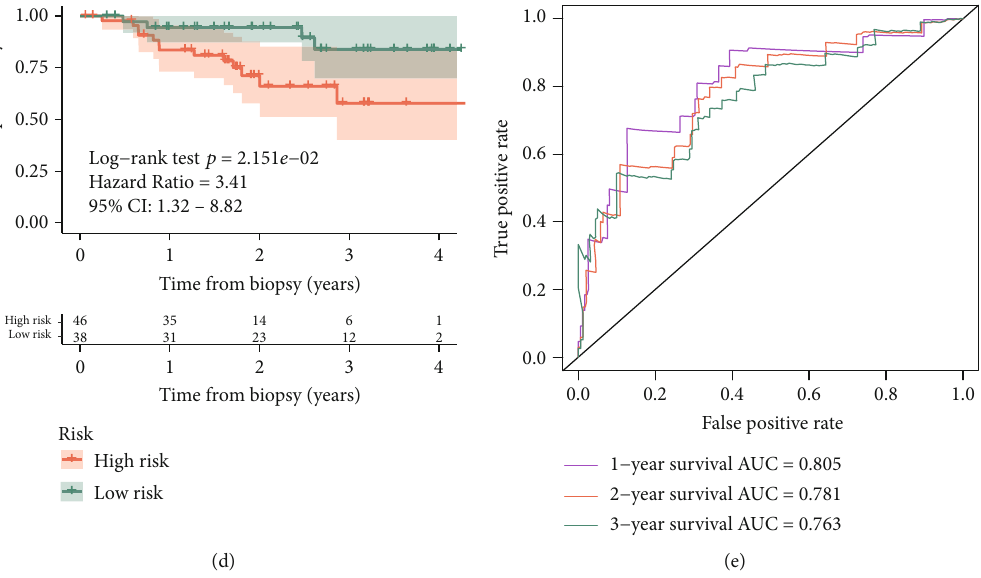
Figure 6: Prognostic analysis of the 4-lncRNA risk score in the testing set of GSE21374 dataset. (a) The curve of risk score. The dotted line represents the cuto ff score which divides the patients into the low-risk group and high-risk group. (b) The survival status of renal allograft. The coral dots represent graft failure while the aquamarine dots represent graft survival. (c) Heat map of the 4-lncRNA expression pro fi les in the low-risk group and high-risk group. (d) KM survival analysis of the risk score model. (e) Time-dependent ROC analysis of the risk score model. KM: Kaplan-Meier; ROC: receiver operating